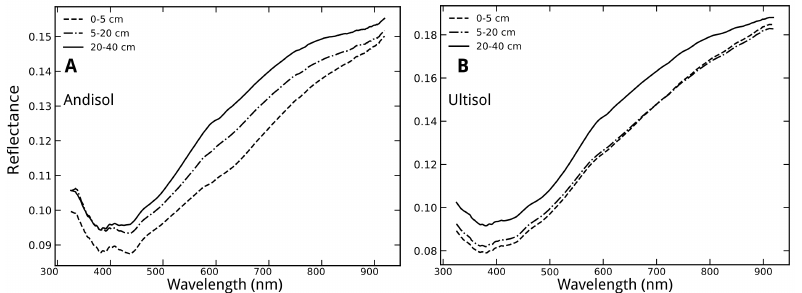
Figure 4. The average of soil reflectance of the three soil depths. ( A ) The spectral separability between depths can be observed from 450 nm; ( B ) for the depths of 0–5 and 5–20 cm the spectral separability was not exhibited, and the curves intersected between 650 and 750 nm.